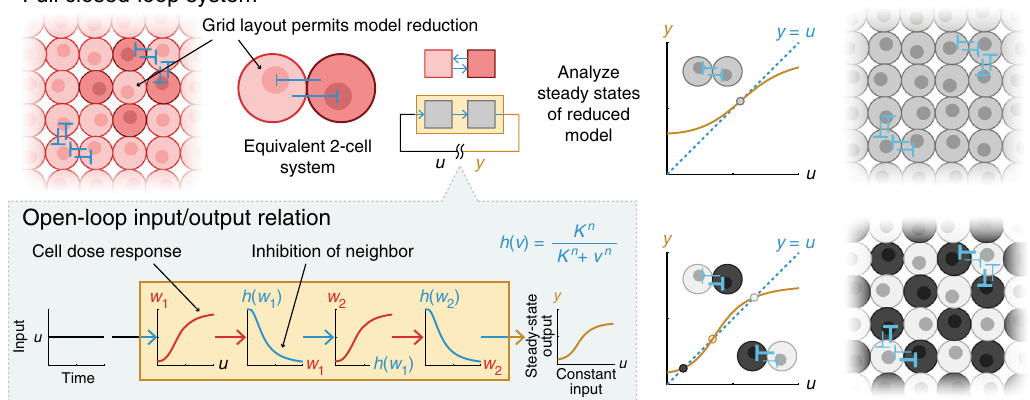
Fig. 2 Spontaneous contrasting patterning in a large lateral inhibition system can be predicted from bistability in a 2-cell system. The bistability of a 2- cell system can be used to evaluate contrasting patterning in a full network of isogenic, mutually inhibiting cells arranged in a grid with periodic boundary conditions. Bistability of the corresponding 2-cell system implies contrasting patterns exist in the full system (see subsection entitled Summary of theory). Bistability can be assessed through an analytical test in which the closed-loop dynamical system is opened into an input/output system by breaking the feedback loop. If a constant-in-time input to the open-loop system produces a steady-state output value equal to the input value, then that value is a steady state for the corresponding closed-loop